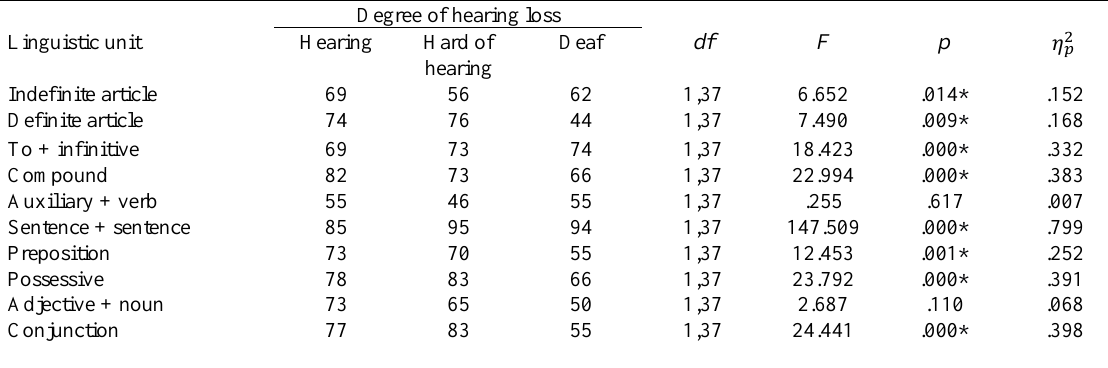
Table 8. Percentage of Experiment 2 participants who preferred the syntactically segmented condition. Degree of hearing